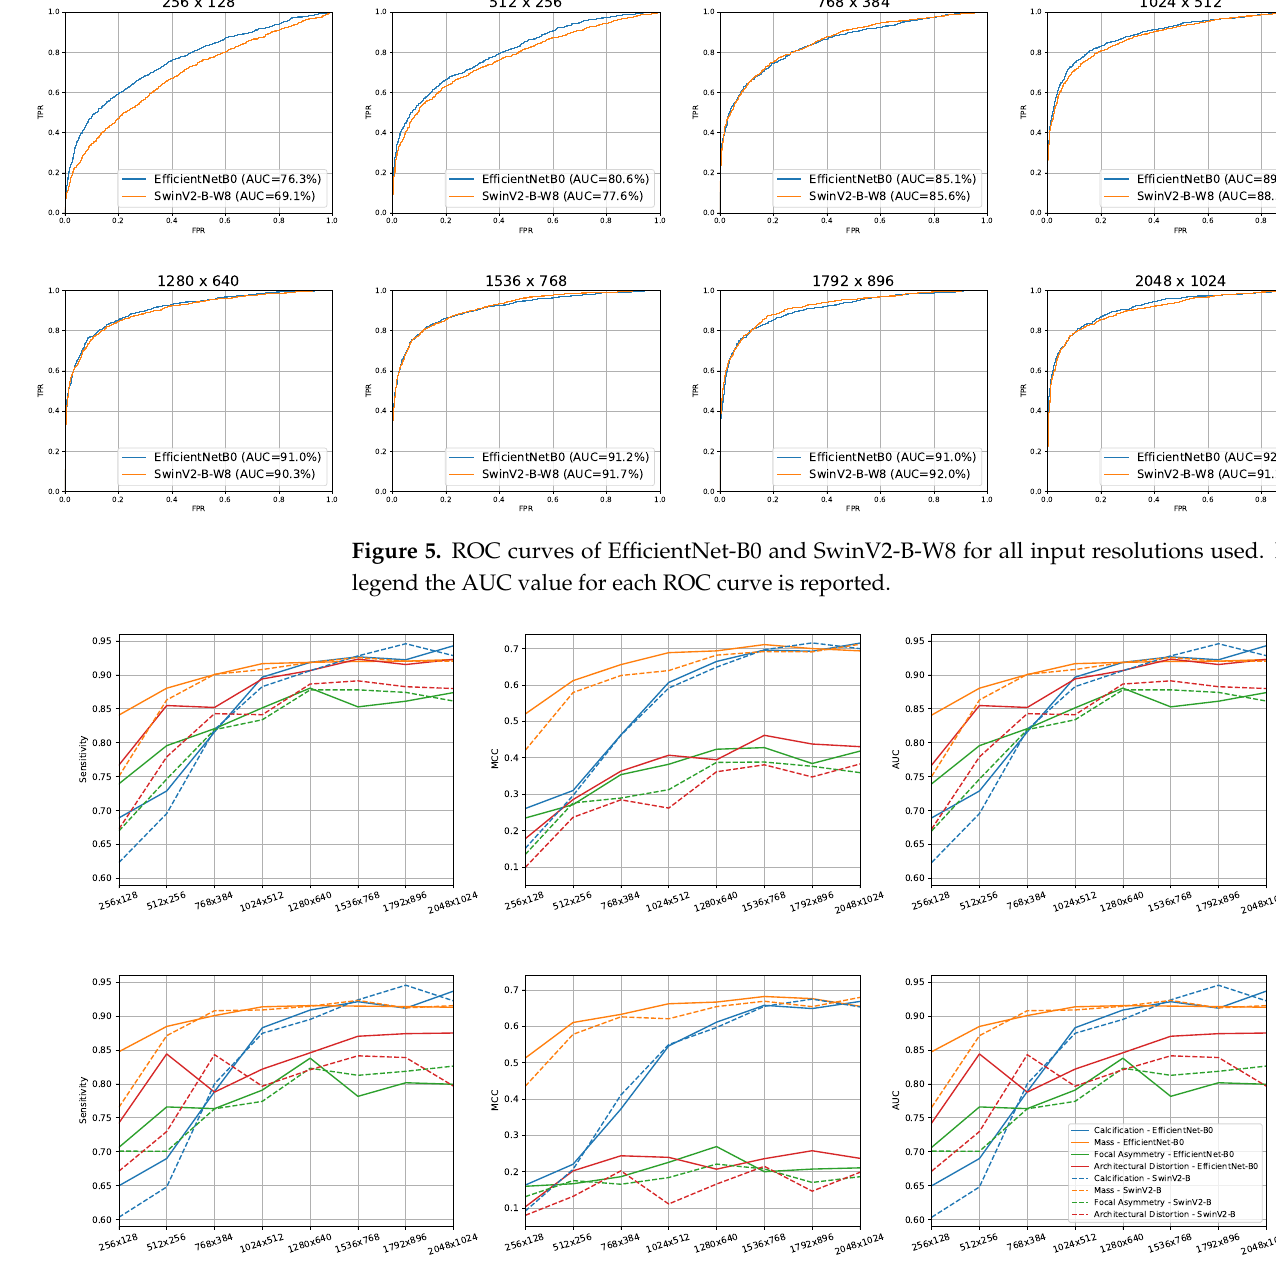
Figure 6. Performance per-lesion in experiments as the resolution changes for each combination of metrics (Sensiticity, MCC, AUC) and image selection approach ( MIXED top row, EXCLUSIVE bottom row). On x-axis the input resolution and on y-axis the value for the metric considered. Continues and dashed line indicate respectively EfficientNet-B0 and Swin-B-W8. Colors represent different lesions (yellow-mass; blue-calcification; green-focal asymmetry; red-architectural